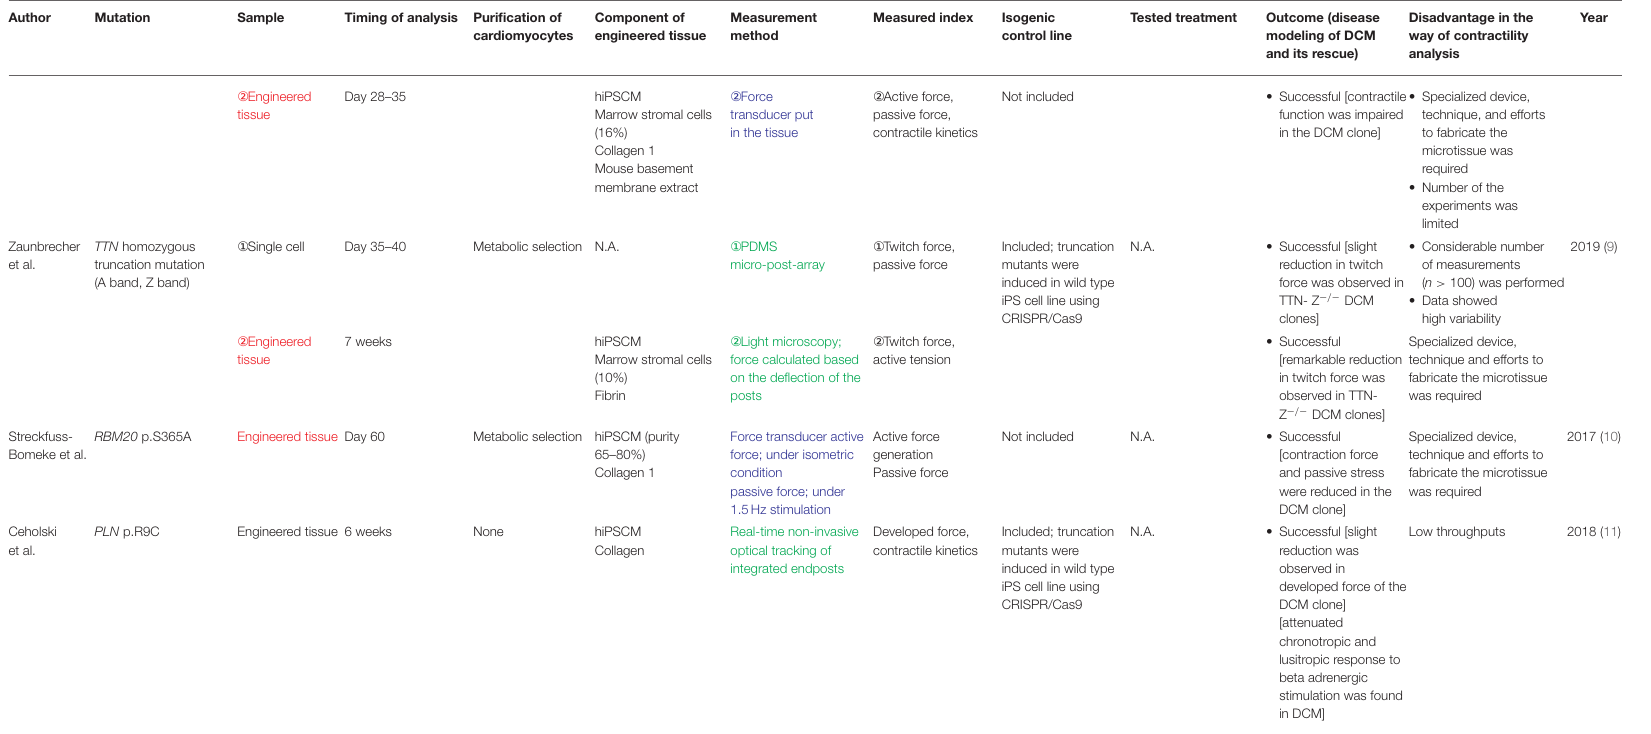
Red, samples prepared in a tissue engineering approach. Blue, parameters directly measured from an attachment on the cell. Green, parameters calculated based on the displacement of spots integrated with the